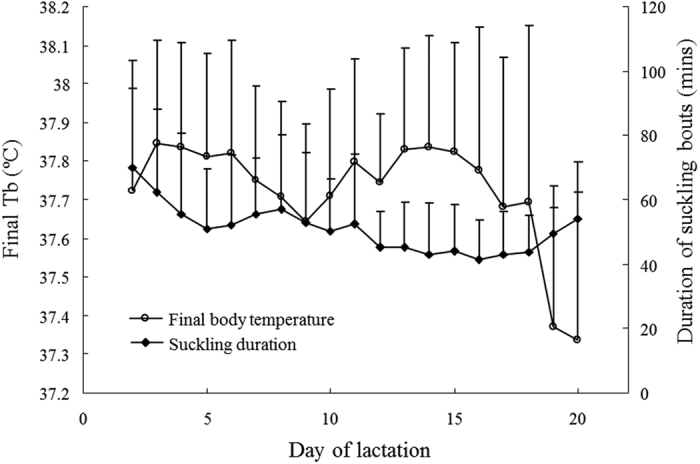
Daily means of final body temperature (Tb) at the end of nursing bouts and duration of nursing bouts.The data are expressed as mean + S.D. (n = 26). Open-circle and closed-diamond symbols represent final Tb and nursing duration, respectively.